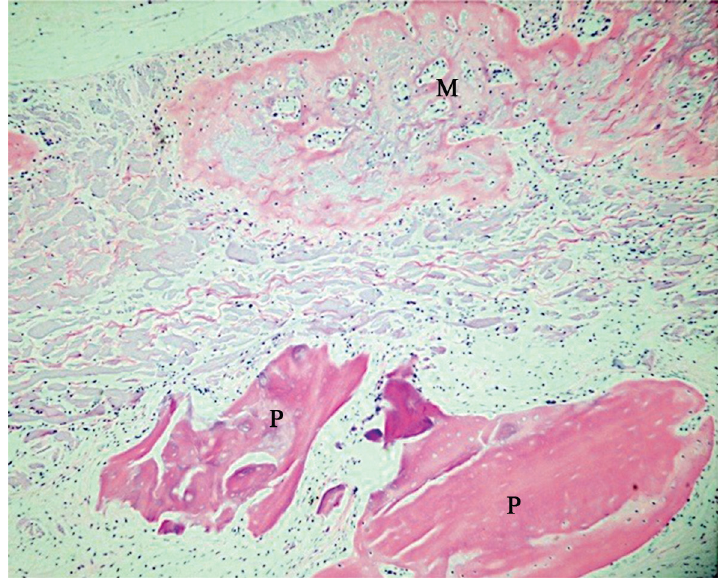
Figure 7- Group AB+M: Central region of surgical defect with new bone formation at the membrane region (M), and some particles of autogenous bone (P) (20x)